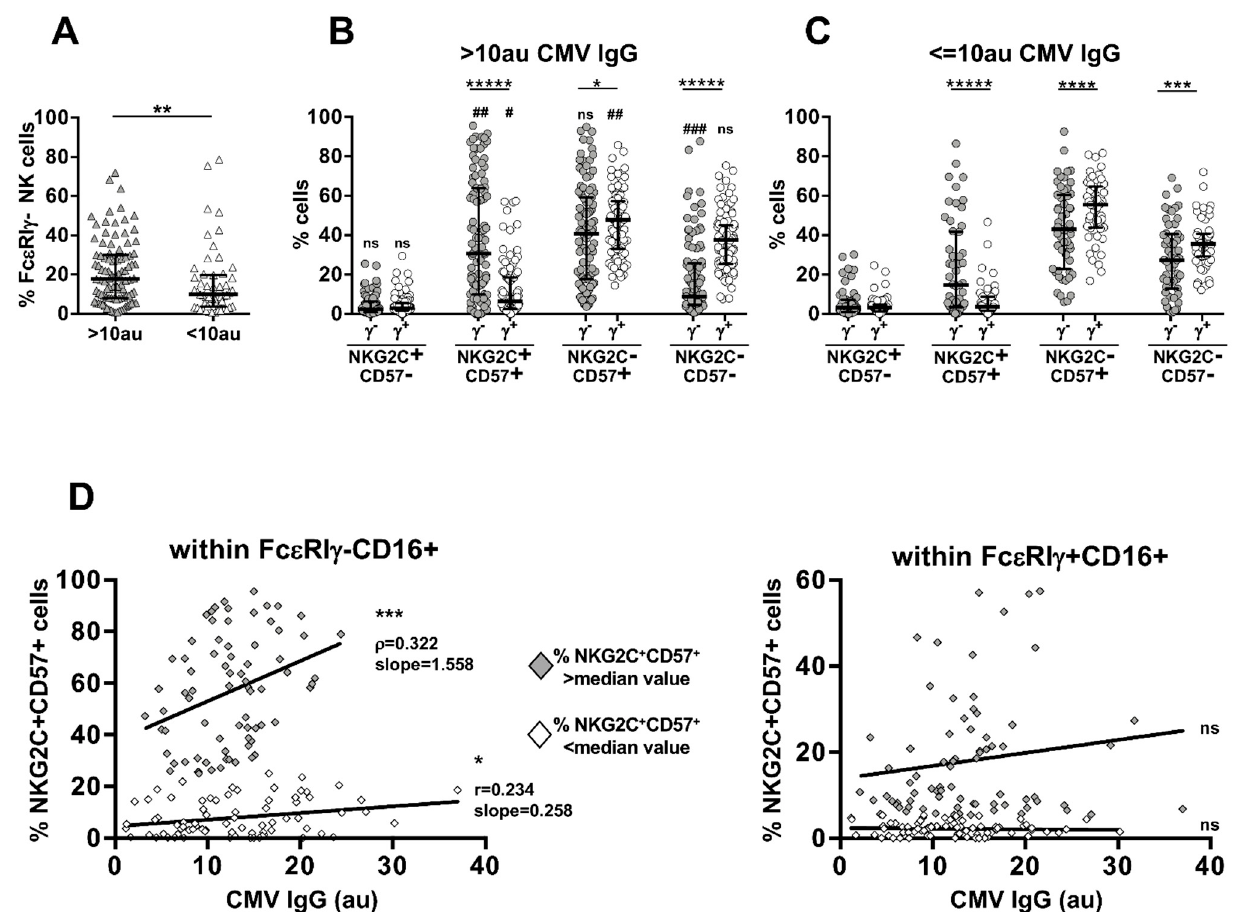
Figure 2. Anti-HCMV IgG levels impact Fc ε RI γ − memory NK cell pool abundance and correlate with the expansion of Fc ε RI γ − NKG2C + CD57 + subset in seropositive individuals. ( A ) Percentage of Fc ε RI γ − memory (within CD16 + CD56 dim ) NK cells in HCMV + healthy donors stratified for higher (>10 arbitrary units, au, grey triangles) or lower ( ≤ 10 au, empty triangles) levels of anti-HCMV antibodies. Relative percentage of Fc ε RI γ − ( γ − , grey circles) and Fc ε RI γ + ( γ + , empty circles) subsets in individuals with >10 au ( B ) or ≤ 10 au ( C ) anti-HCMV antibodies. Bars represent median with interquartile range. p values of pairwise comparisons were calculated with Wilcoxon and Mann–Whitney (>10 au vs. ≤ 10 au) non-parametric tests, as appropriate. (*) symbol indicates statistical comparison with corresponding Fc ε RI γ + subset (Fc ε RI γ − vs. Fc ε RI γ + ): (*) < 0.05, (**) = 0.01, (***) < 0.005, (****) < 0.001, (*****) < 0.00001; (#) symbol indicates statistical comparison with corresponding subset of individuals producing lower levels of anti-HCMV antibodies (>10 au vs. ≤ 10 au): (#) < 0.05, (##) < 0.01, (###) < 0.0005. ( D ) Correlation between the relative abundance of Fc ε RI γ − (left panel) or Fc ε RI γ + (right panel) NKG2C + CD57 + cells and anti-HCMV antibody concentration. Individuals possessing a larger (higher the median value, grey diamonds) or smaller (lower than median value, empty diamonds) given subset were analysed separately. Spearman’s correlation coefficients (r) and curve slopes are reported when 2-tailed p values were significant (<0.05): (*) < 0.05, (***) < 0.005.